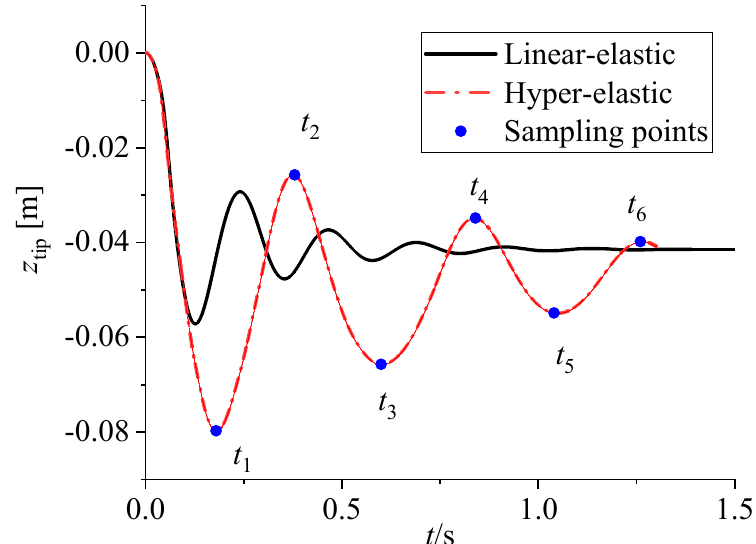
Figure 9. Tip displacement of the membrane with linear and hyper-elastic materials ( d = 0.18 m).